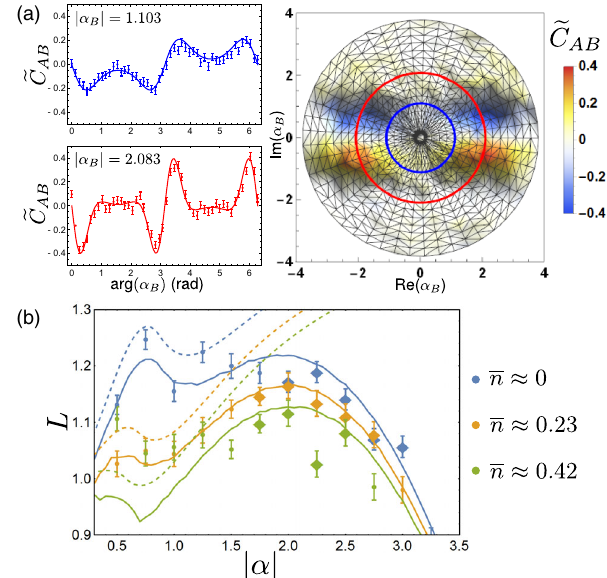
FIG. 4. Two time correlators and violation of a Leggett-Garg inequality. (a) Two-time correlation measurement in the asym- metric implementation performed on an initial ground-state cooled ion as a function of the second displacement α B . The fixed experimental settings were α A ¼ 2 . 1 , ϕ A ¼ 0 , ϕ B ¼ π = 2 . The full data set is shown in the false-color plot to the right. Two cuts through this data set with fixed j α B j are indicated in this false-color plot and explicitly plotted to the left, where solid lines show the expectations for an ideal experiment. (b) Violation of a Leggett-Garg inequality for increased modular measurement displacements j α j and three different initial temperatures. Solid lines show the expected violation including simulated qubit and motional dephasing as well as phase calibration errors (see Appendix N); the dashed lines instead are the exceptions for an ideal experiment. Violations are observed over a wide range of α for all investigated temperatures. With a ground-state cooled ion, violations are observed up to α ¼ 3 . The points highlighted with a diamond violate the LGI when being penalized by the built-in theoretical amount of SIT (Appendix O). The discrepancy between the data and the simulation at ¯ n ¼ 0 . 42 is due to additional experimental fluctuations in the preparation of this higher thermal occupation. All error bars are propagated from the SEM errors because of quantum projection